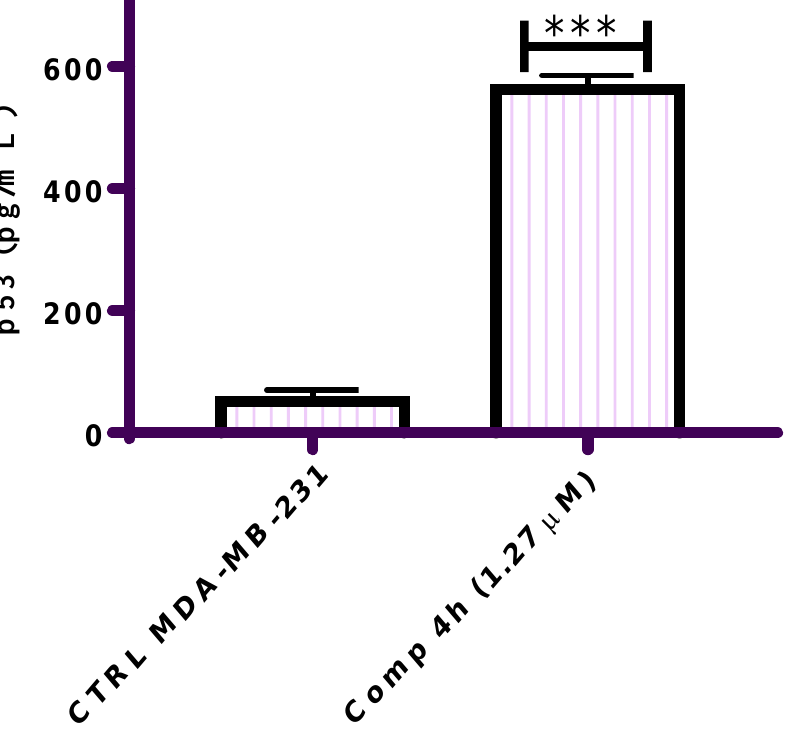
Figure 7. Graphical representation for the effect of Schiff base 4h on the level of p53 in MDA-MB-231 cells for 24 h. All values are presented as mean value ± SD and statistical analyses were carried out using one-way analysis of variance (ANOVA) followed by Tukey’s multiple comparison test (*** p <